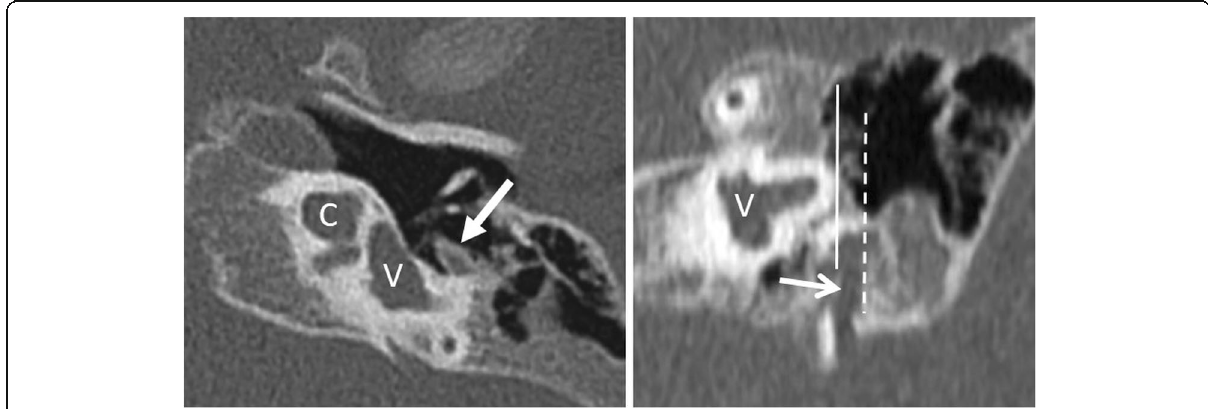
Fig. 12 A 1-year-old male patient, with bilateral severe SNHL from birth. HRCT axial image (left image) shows incomplete partition type I with cystic cochlea (C) and vestibulum (V). The horizontal segment of the facial nerve (arrow) is lateralized. HRCT coronal image (right image) shows an interrupted line corresponding to the most lateral aspect of the vertical segment of the facial nerve (open arrow) lateral to the continuous line corresponding to the most lateral bony aspect of the lateral semicircular canal. The normal location of the vertical segment is medial to the lateral semicircular